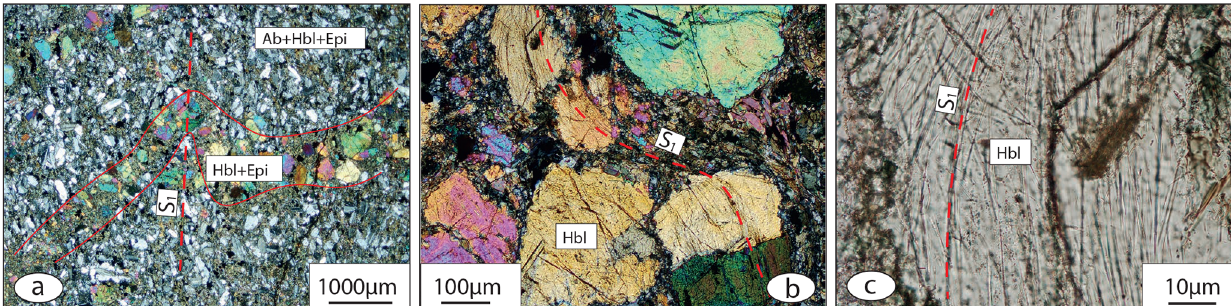
Figure 16. (a) Albite + hornblende + epidote metamorphic fabric aligned with axial planar S 1 . Folded vein hosting hornblende + epidote. (b) Syn-tectonic growth of hornblende. (c) Needle-shaped mineral forming traces of S 1 in hornblende. All images from X690267 Y7529944, Ekströmsberg. Coordinates in Sweref99. Hbl: hornblende; Ab: albite; Epi: